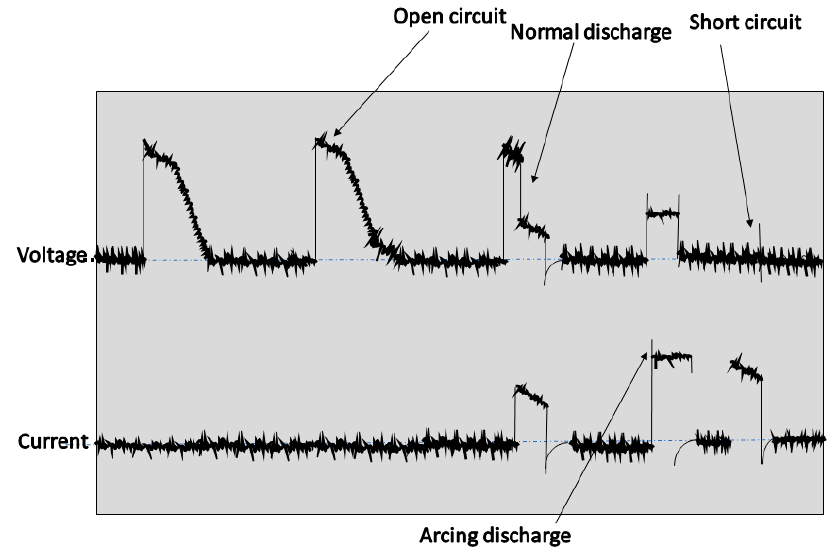
Figure 7. Voltage and current waveforms for various types of pulses with a short circuit and open circuit [88].